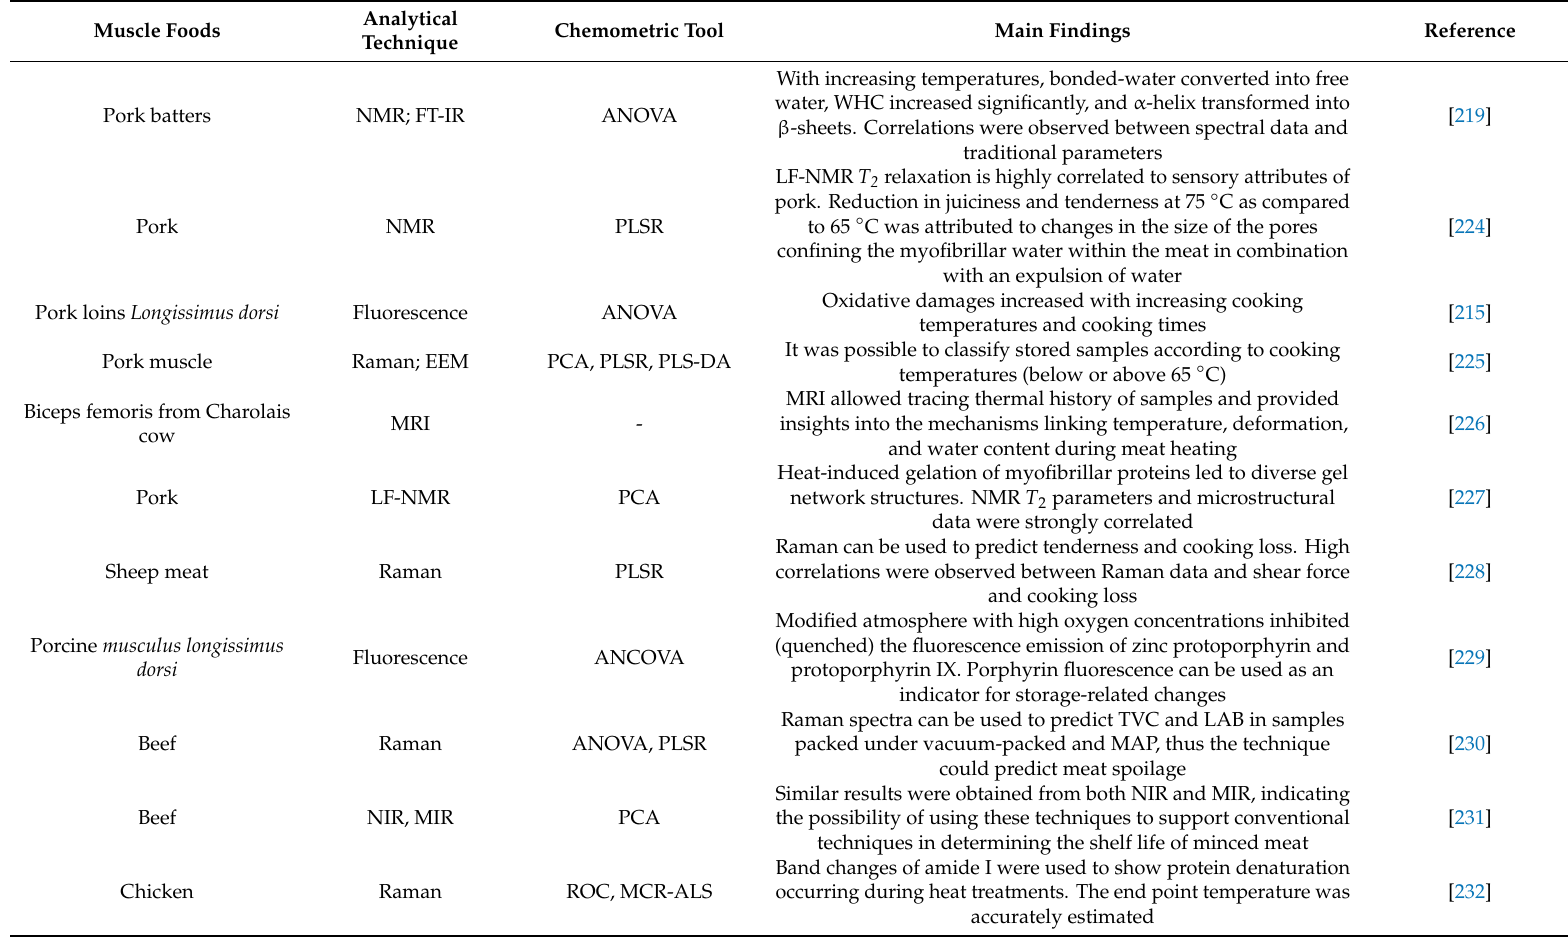
Table 4. Some examples of application of spectroscopic methods for monitoring thermal and non-thermal treatments in